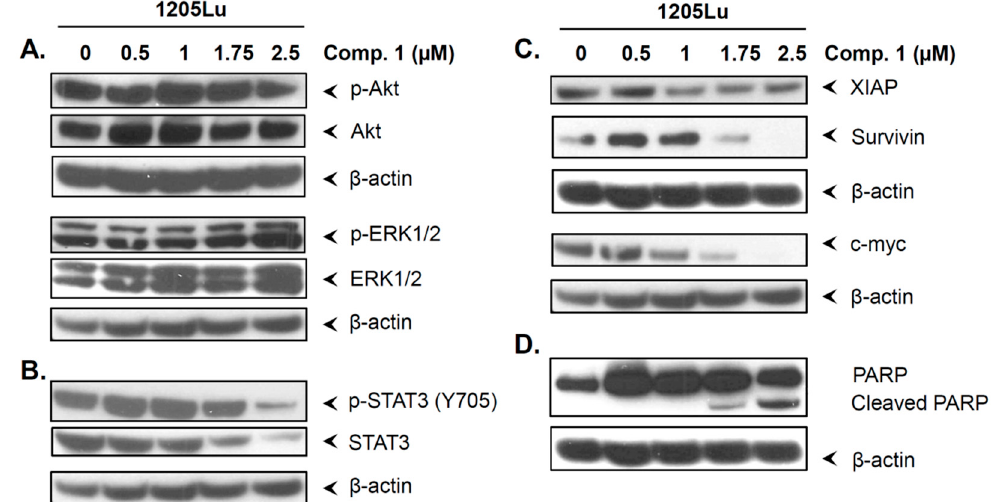
Figure 5. Compound 1 downregulated STAT3 and its downstream target proteins expression. 1205Lu cells were incubated with either DMSO (control) or compound 1 for 24 h. Whole cell lysates were subjected to western blot analysis. Expression of different proteins related to STAT3 and its downstream targets ( A – D ) were monitored. ß-actin was used as a loading control.